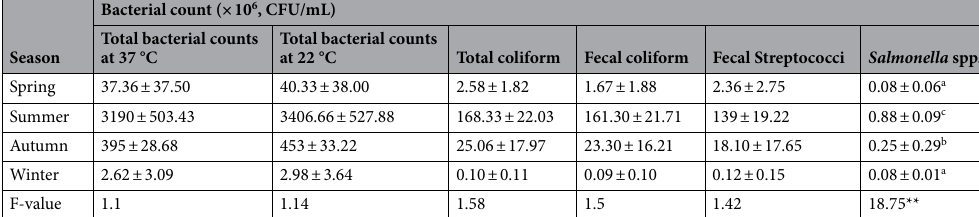
Table 2. Seasonal variations of bacterial indicators and Salmonella spp. in drainage water. F-values represent ANOVA and letters (post-hoc Duncan test) for significant levels of seasonal variations. ** p ≤ 0.01. Small letters “a”, “b” and “c” indicate to significant variation of post-hoc Duncan